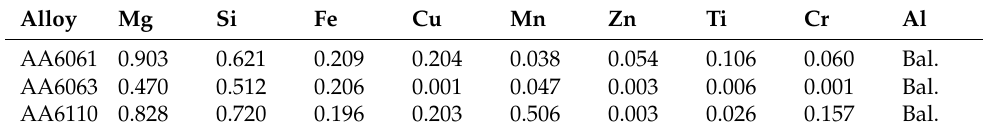
Table 1. Chemical compositions of the alloys in